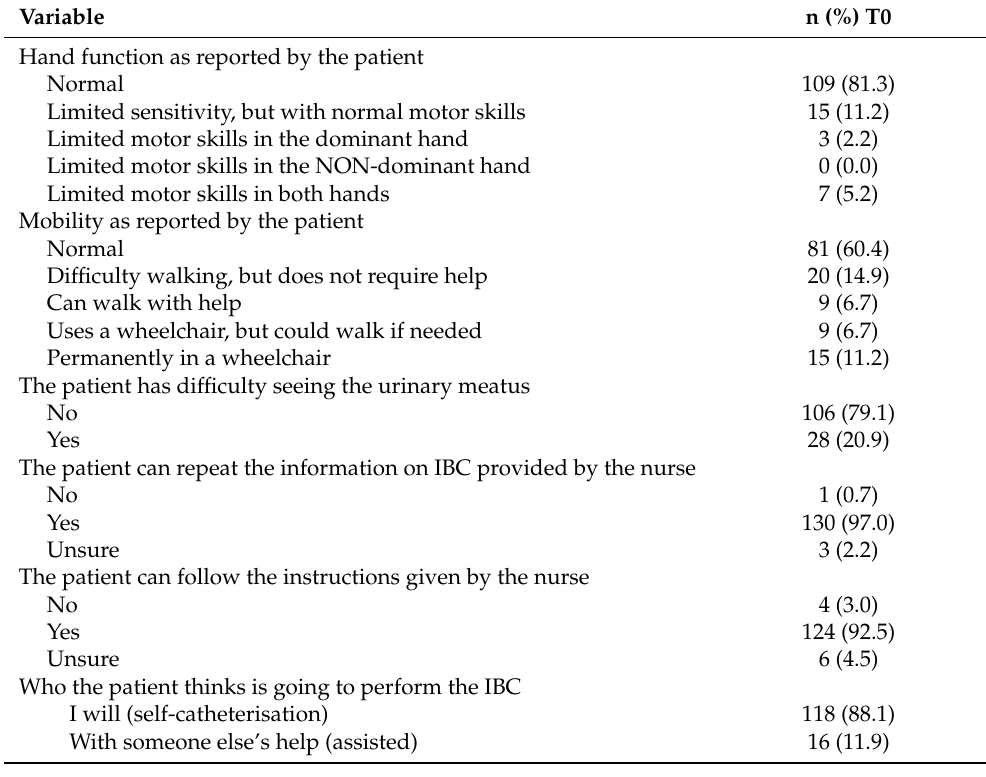
Table 3. Characteristics relating to the ability to